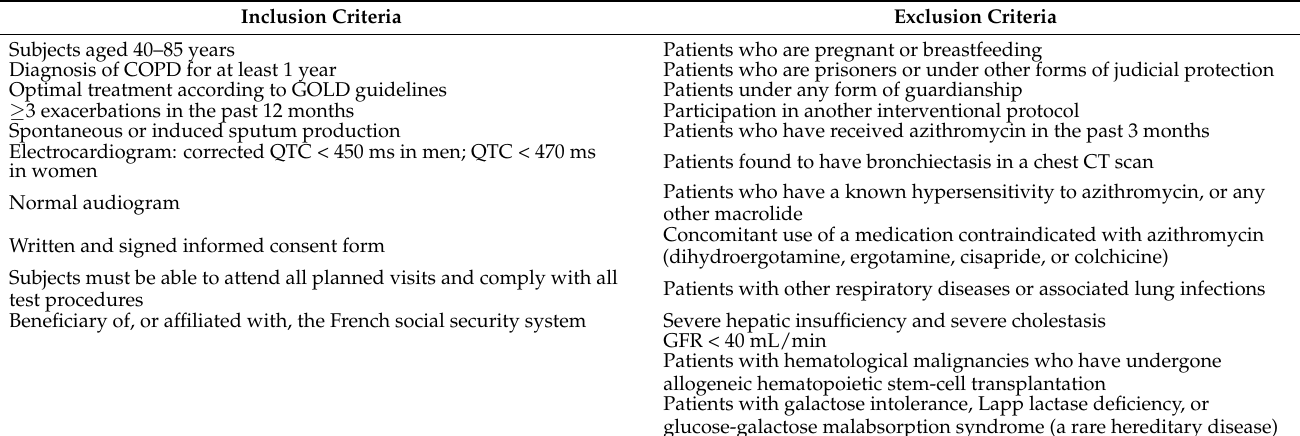
Table 1. Eligibility Criteria. Inclusion Criteria